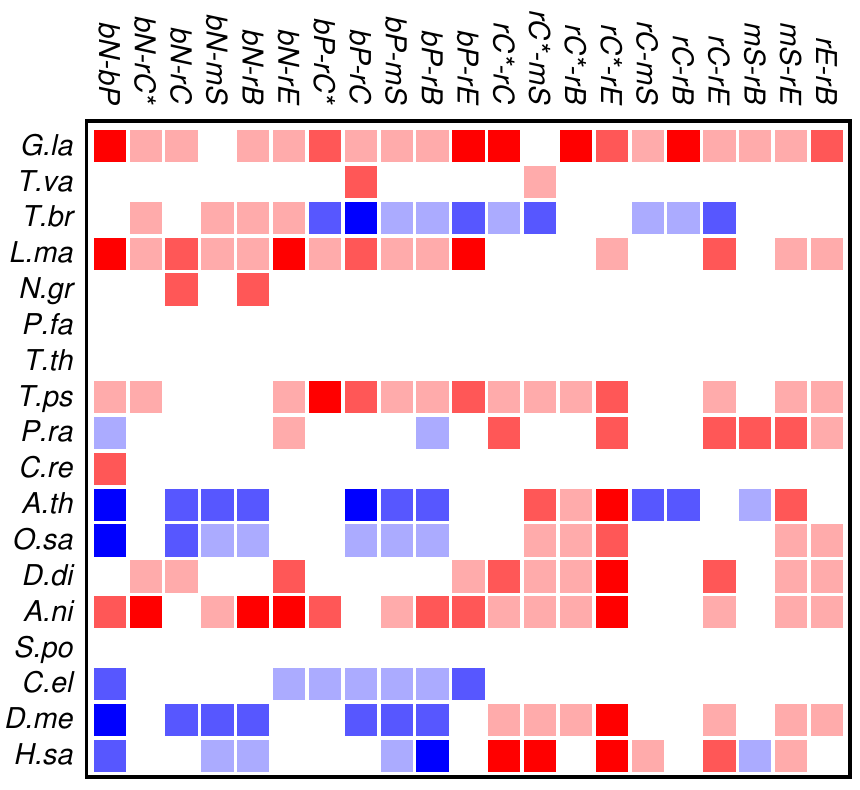
Figure 3. Summary of domain co-occurrences of functional classes of protein domains in zinc finger proteins. See Figure 2 for the color